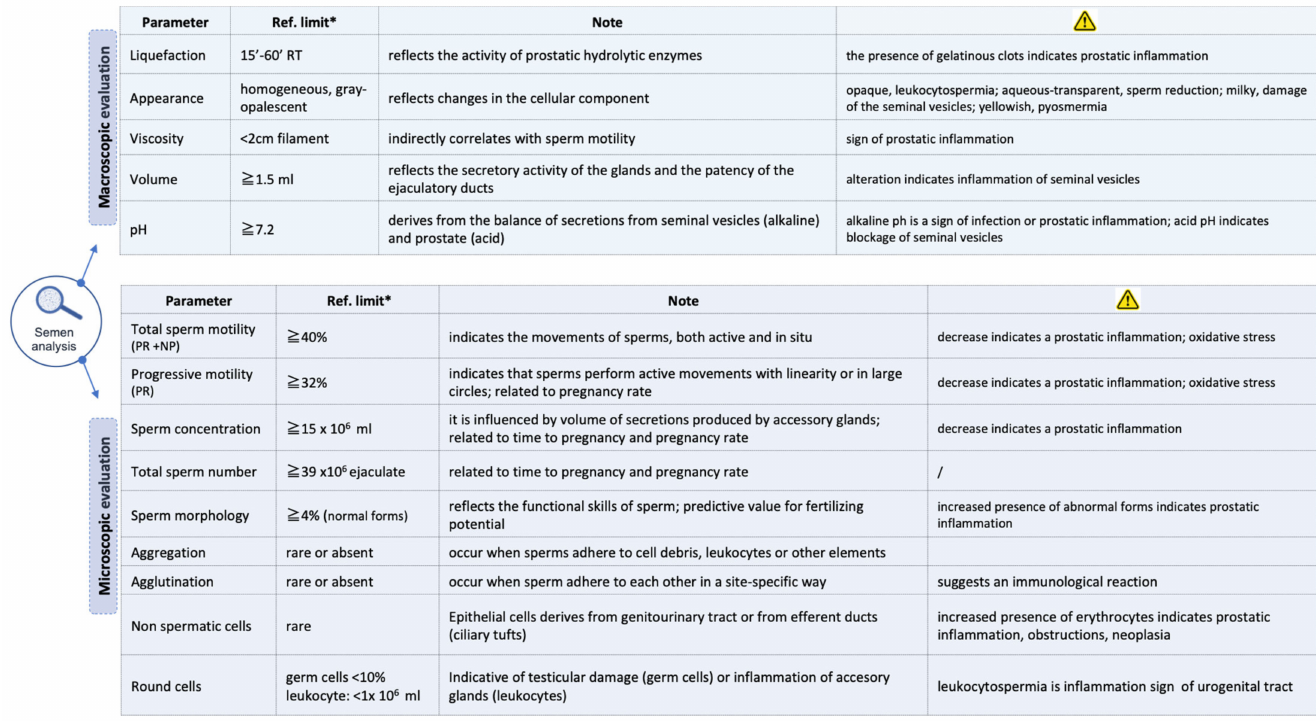
Figure 2. Semen analysis. Macroscopic and microscopic parameters used to evaluate the seminal sample. * The reference values refer to the lower 5th centiles (95% confidence interval) regarding the standards of conventional statistics applied to clinical